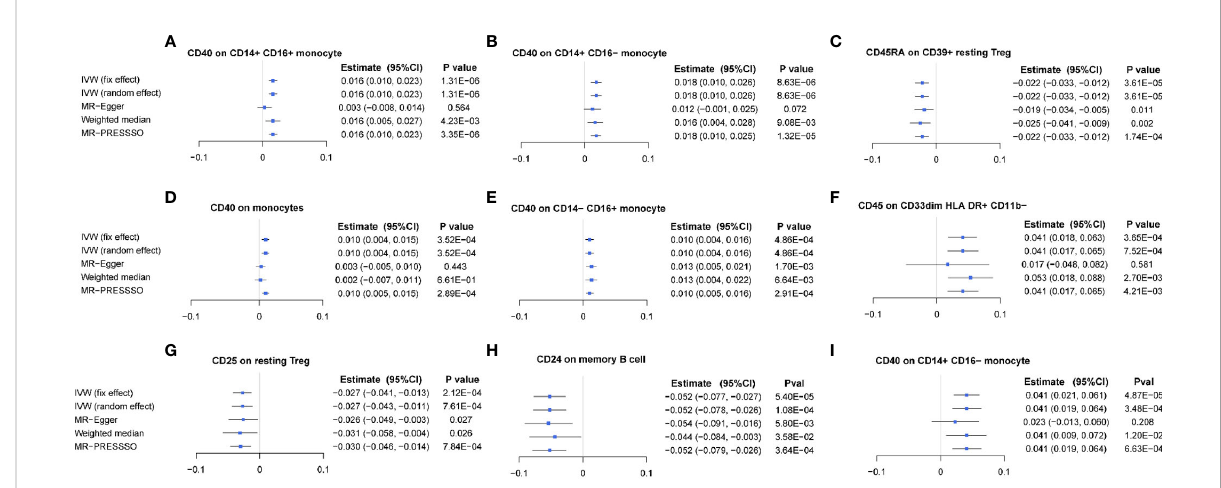
FIGURE 2 Forest plot of causal effects of different immune traits (MFI) on BMDs. (A) CD40 on CD14 + CD16 + monocyte on TB-BMD. (B) CD40 on CD14 + CD16 - monocyte on TB-BMD, (C) CD40 on CD14 − CD16 + monocyte on TB-BMD, (D) CD40 on monocytes on TB-BMD, (E) CD45RA on CD39 + resting Treg on TB-BMD, (F) CD25 on resting Treg on TB-BMD, (G) CD45 on CD33dim HLA DR + CD11b − on TB-BMD, (H) CD24 on memory B cell on FA-BMD, (I) CD40 on CD14 + CD16 − monocyte on FA-BMD. MFIs, median fl uorescence intensities, TB, total body; FA, forearm; BMD, bone mineral